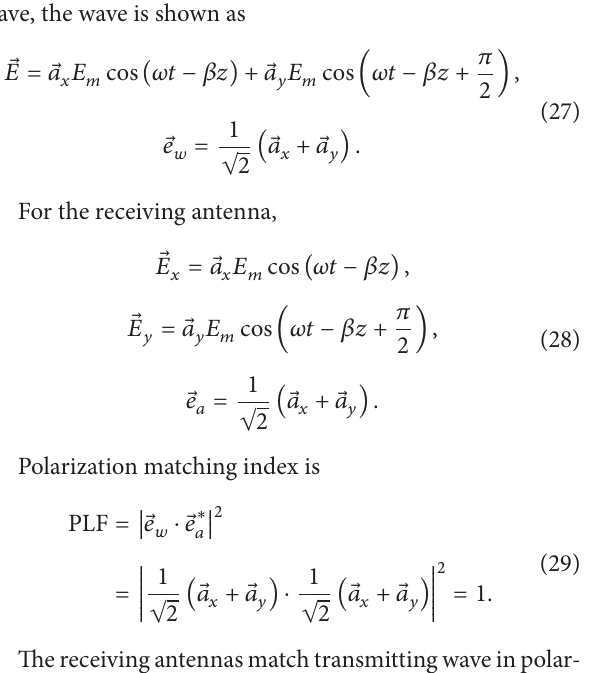
The receiving antenna cannot get power, because they did not match in rotation direction. The same result comes with horizontal/vertical polarized antenna receiving vertical/ horizontal polarized wave.